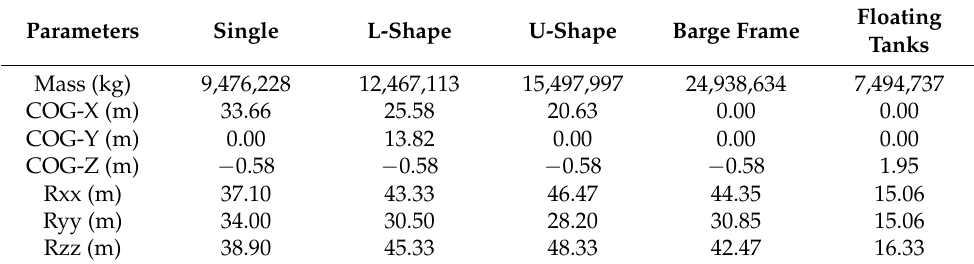
Table 2. Mass properties of the floating breakwaters and storage tanks